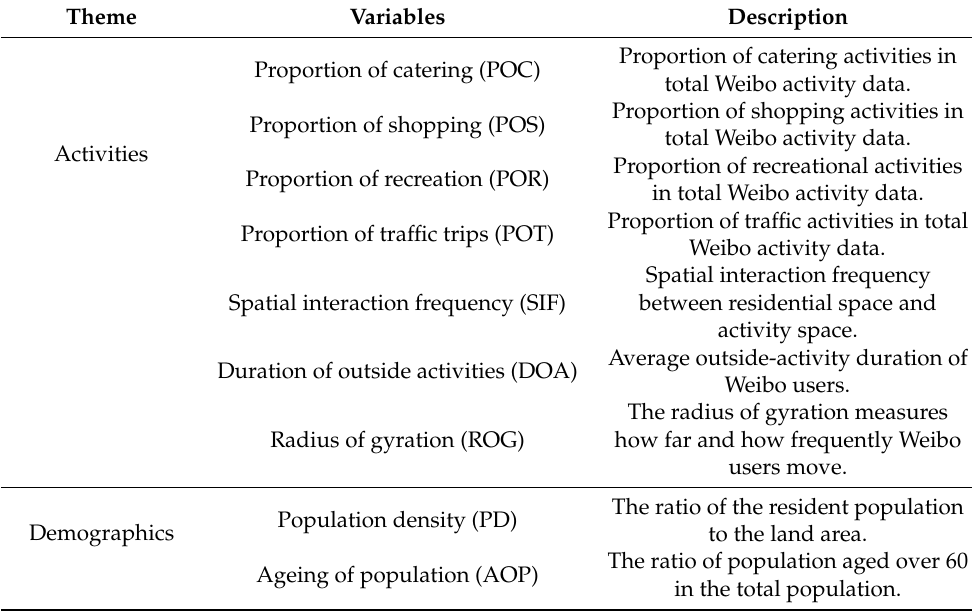
Table 1. Variable